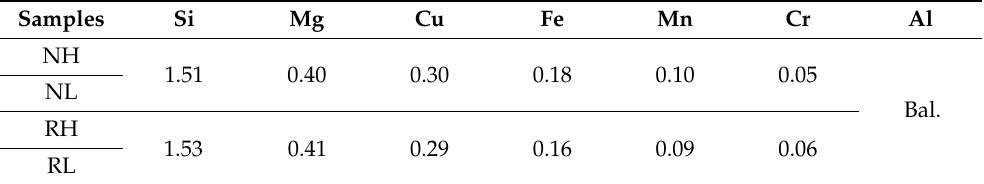
Table 1. Chemical compositions (in wt.%) of the Al-Si-Mg-Cu alloy sheets. Samples Si Mg Cu